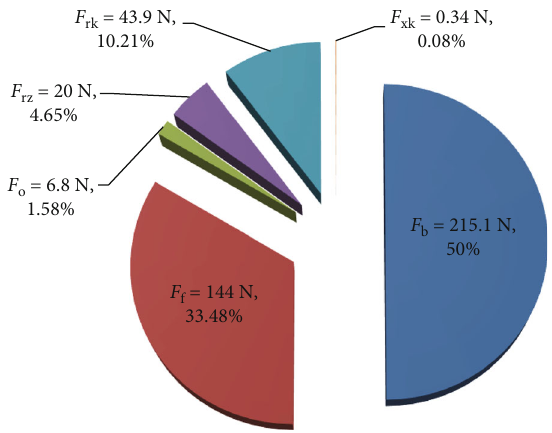
Figure 5: Extension limit in fl uenced by the pump pressure.